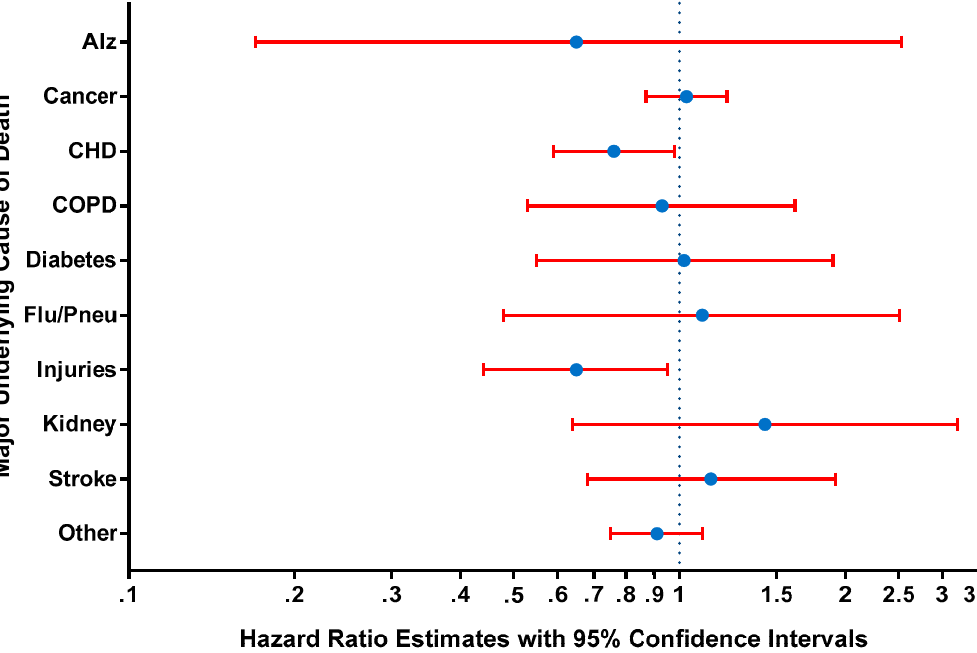
Figure 3. Hazard ratio estimates from Cox proportional hazards regression models for paid sick leave and mortality by major underlying cause of death, USA National Health Interview Surveys 2000–2002 ( n = 57,323). All models adjusted for age, gender, educational attainment, income, history of a chronic condition (heart disease, stroke, hypertension, diabetes, cancer, asthma, or chronic obstructive lung disease) and survey year. ‘Alz’ = Alzheimer’s disease. ‘CHD’ = heart diseases. ‘COPD’ = chronic lower respiratory diseases. ‘Flu/Pneu’ = influenza and pneumonia. ‘Injuries’ = unintentional injuries. ‘Kidney’ = nephritis, nephrotic syndrome, and nephrosis. ‘Stroke’ = cerebrovascular diseases. ‘Other’ = all other causes.